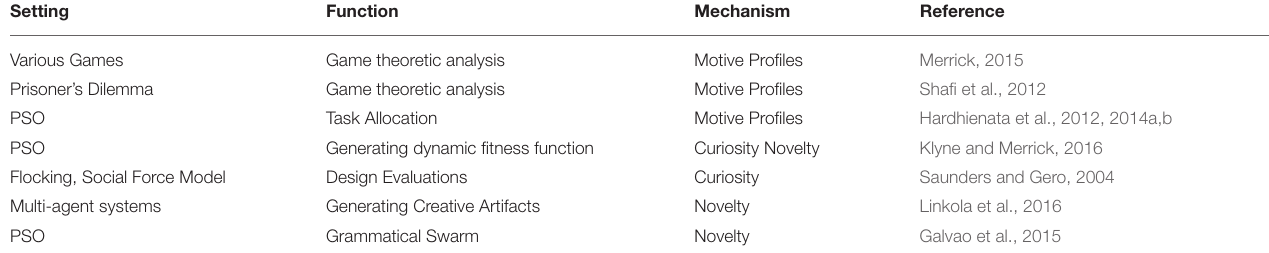
TABLE 6 | A summary of the work using motivation in social context in terms of their setting, function and mechanism. Setting